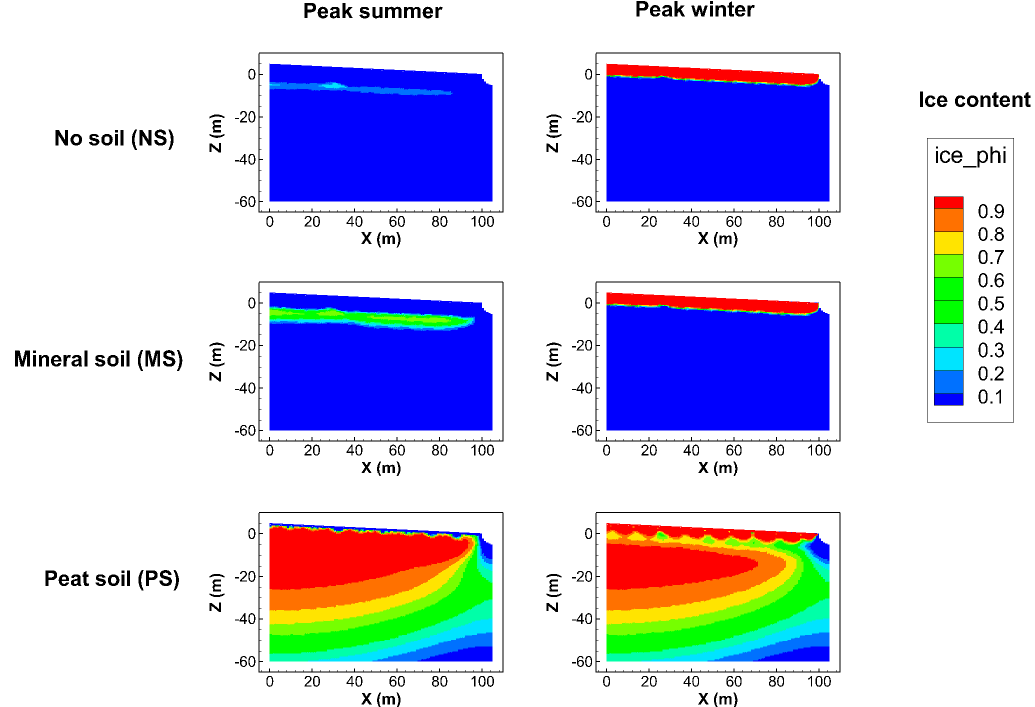
Figure A2. Resulting ice content conditions for the simulation cases of no soil (NS), mineral soil (MS), and peat soil (PS) in peak summer ( left ) and peak winter ( right ) after a 1 °C increase in surface temperature over 100 years.